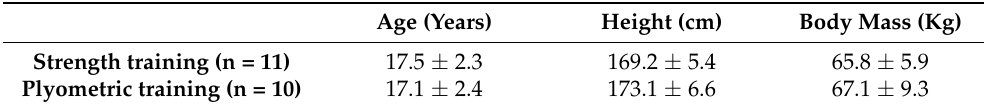
Table 1. Descriptive information of the strength and plyometric training